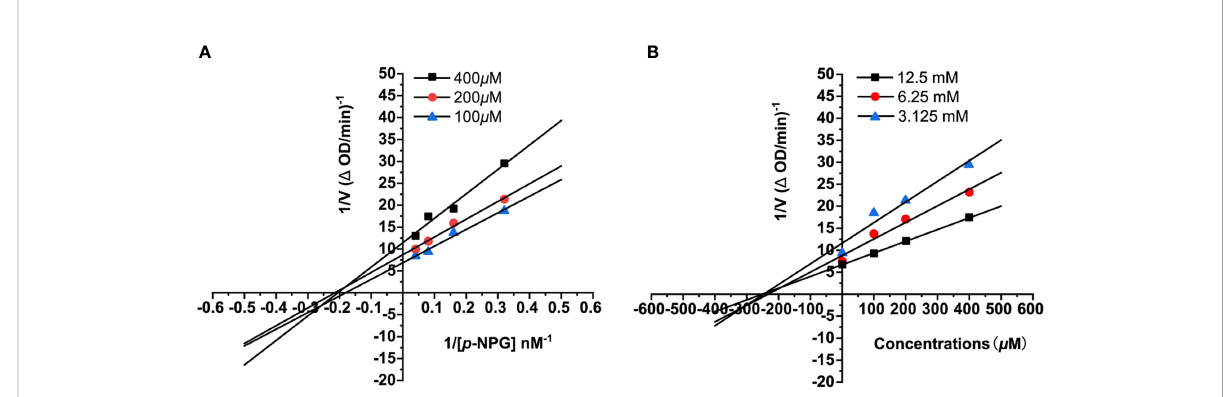
FIGURE 5 The Lineweaver – Burk (A) and Dixon (B) plots for a -glucosidase inhibition of compound